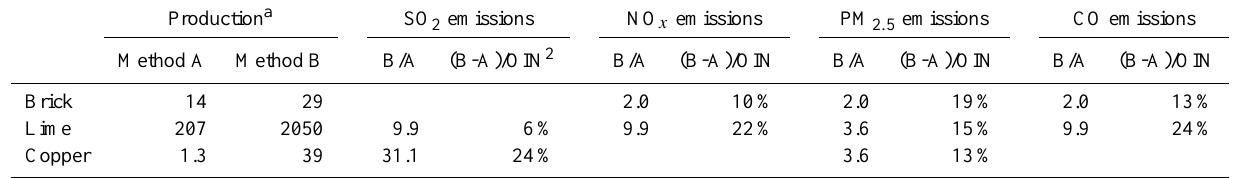
Table 3. Comparisons of emission estimations using method A (plant-by-plant survey) and B (downscaling from provincial levels) for brick, lime, and copper production in Nanjing,